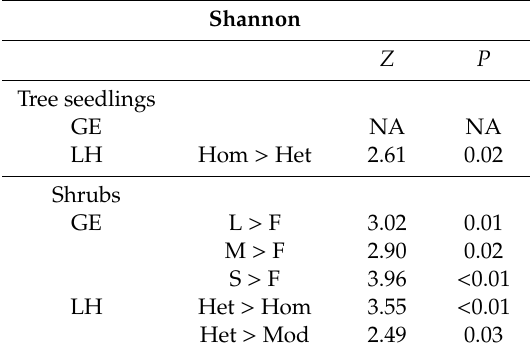
Table 4. Specific hypotheses regarding diversity response toward gap / forest environment (GE) (forest (F) understory, small (S) gaps, medium (M) gaps, large (L) gaps) and landscape heterogeneity (LH) (heterogeneous (Het), moderate (Mod), homogenous